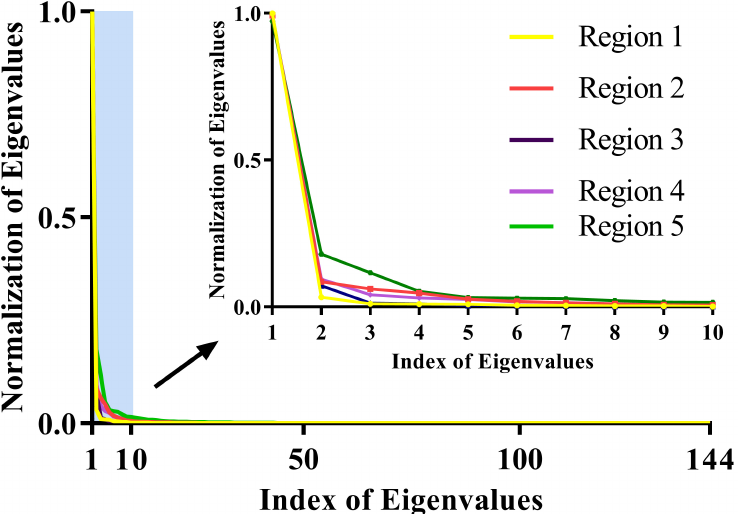
Figure 5. Distribution of eigenvalues in corresponding covariance matrix (the vertical axis indicates normalized eigenvalue and the horizontal axis denotes indexes of descending